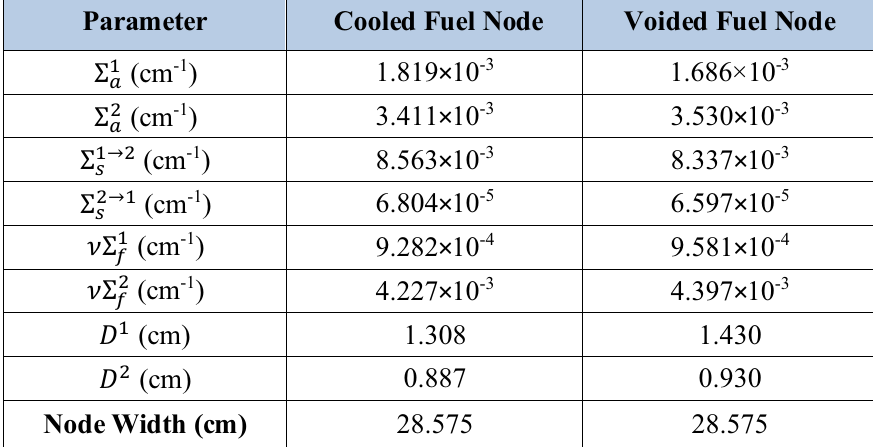
Table IV. Node-homogenized Parameters for the Cooled and Voided Fuel Nodes